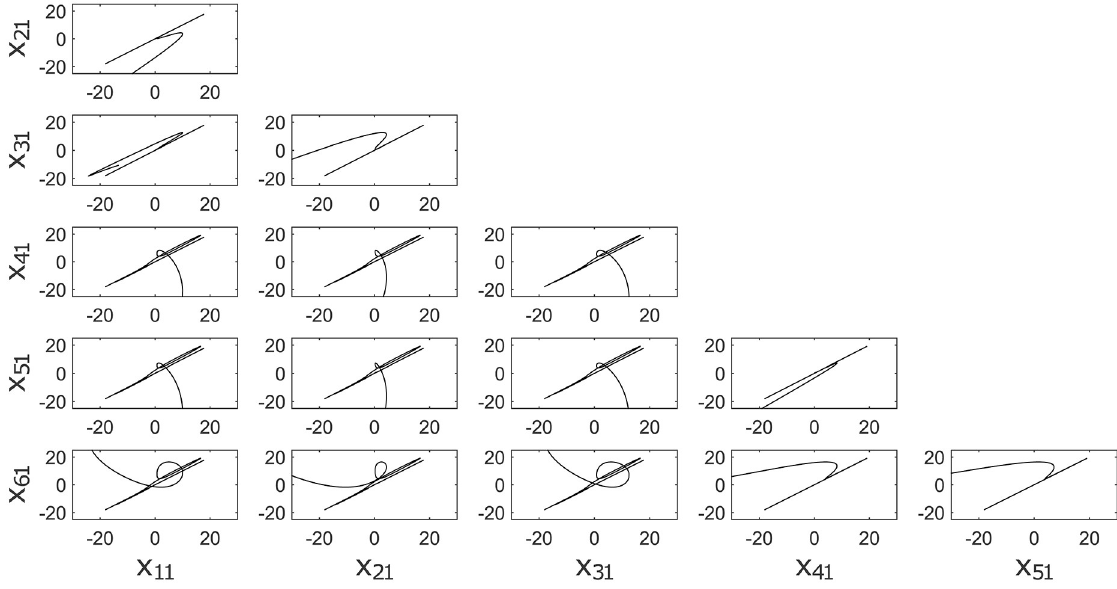
Fig 14. Output Synchronization graphics for different chaotic systems in a Tree topology.